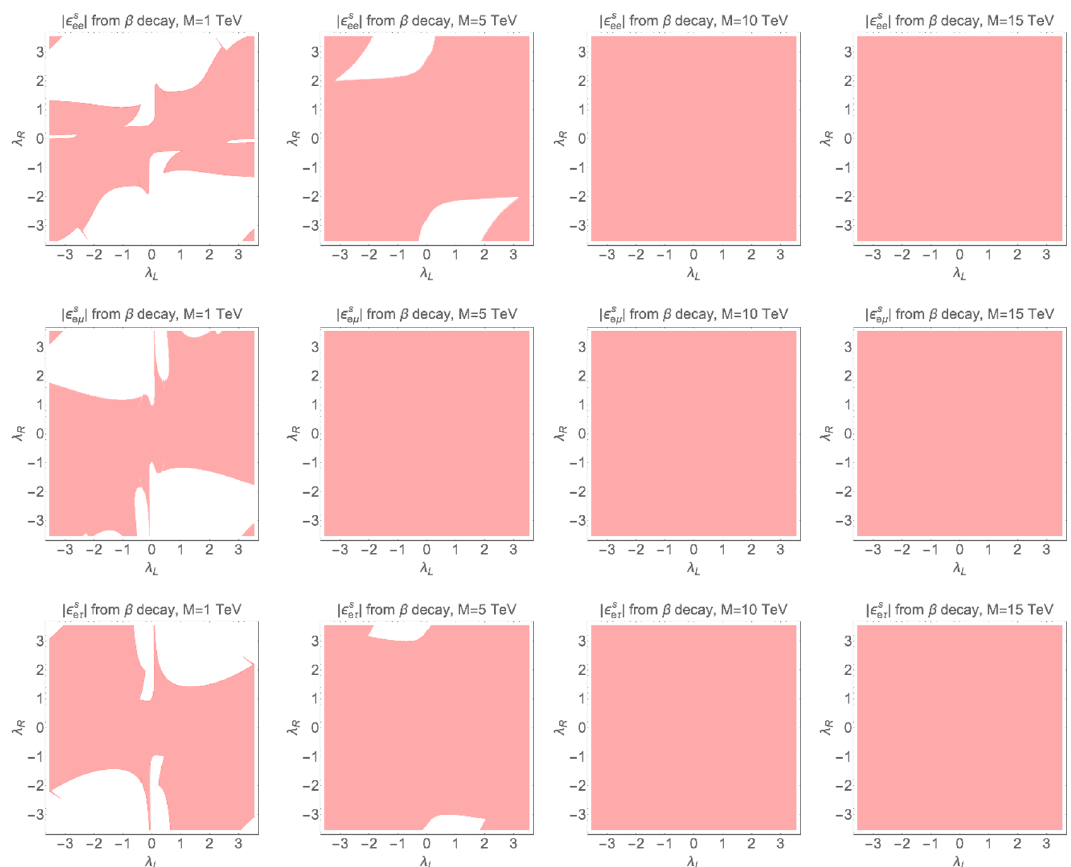
Figure 7 . Constraints on the simplified leptoquark model parameter space from current constraints on | (cid:15) s | ( ‘ = e, µ, τ ) from beta decay summarized in table 4. The pink region(s) in each figure is e‘ (are) still allowed at 95% CL, obtained with fixed leptoquark mass M